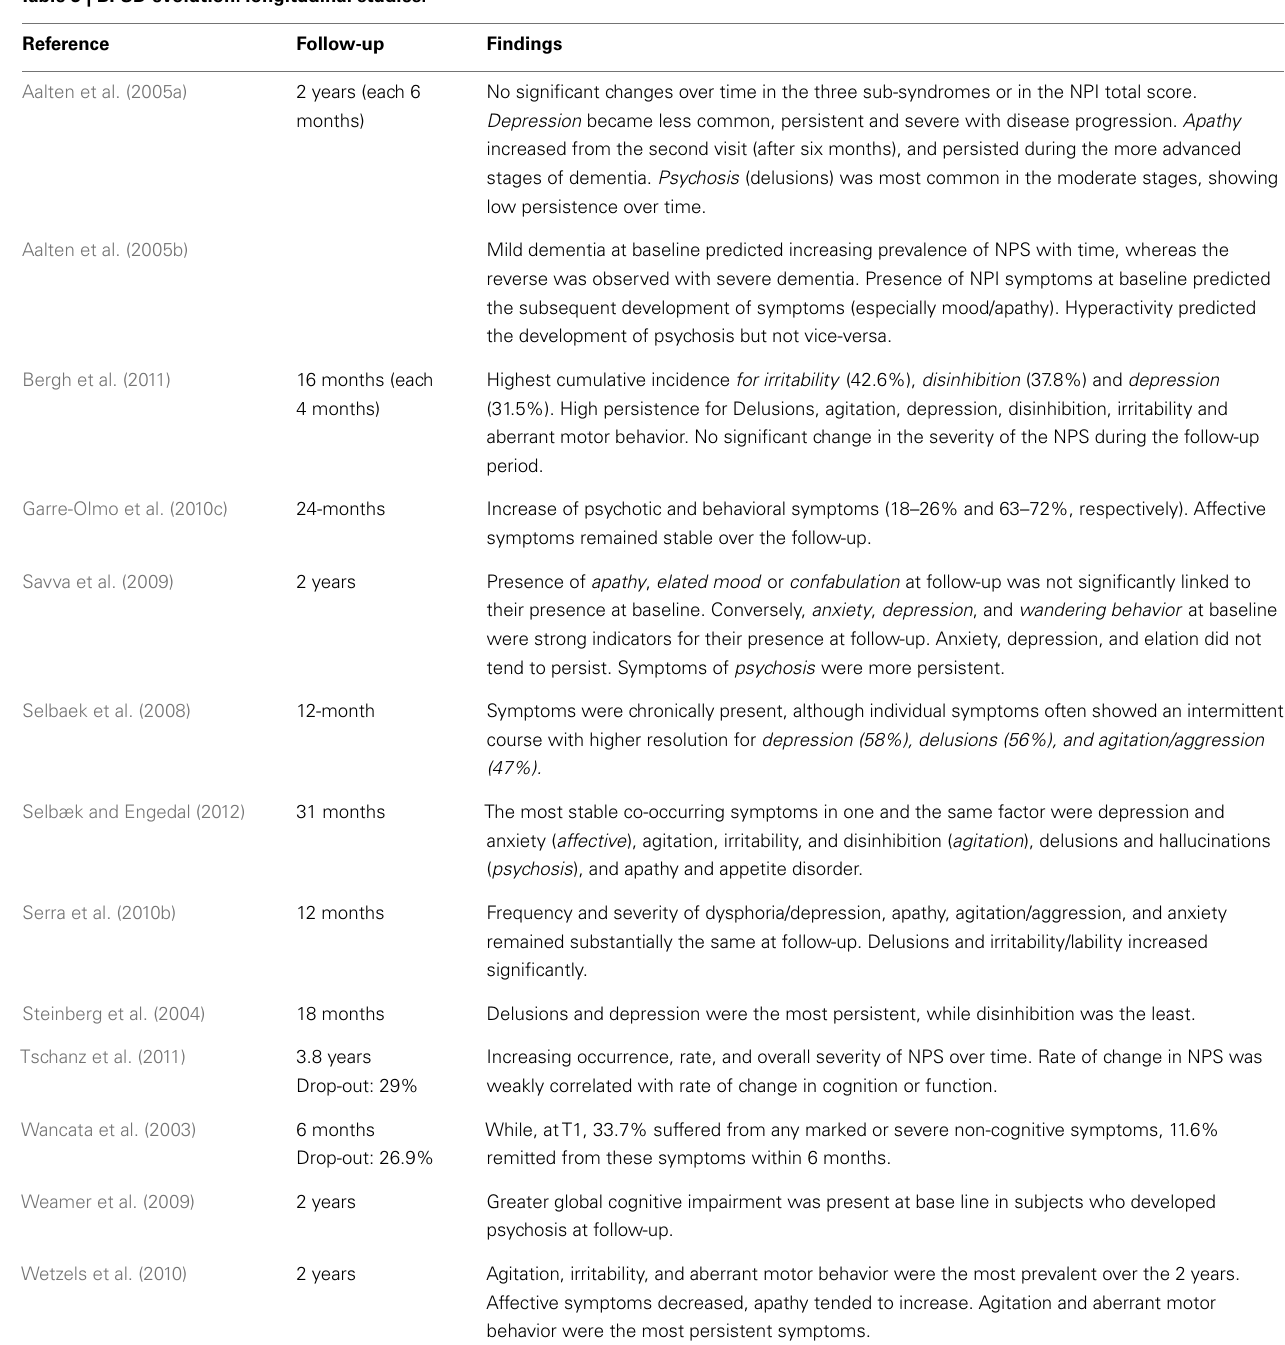
Table 3 | BPSD evolution: longitudinal